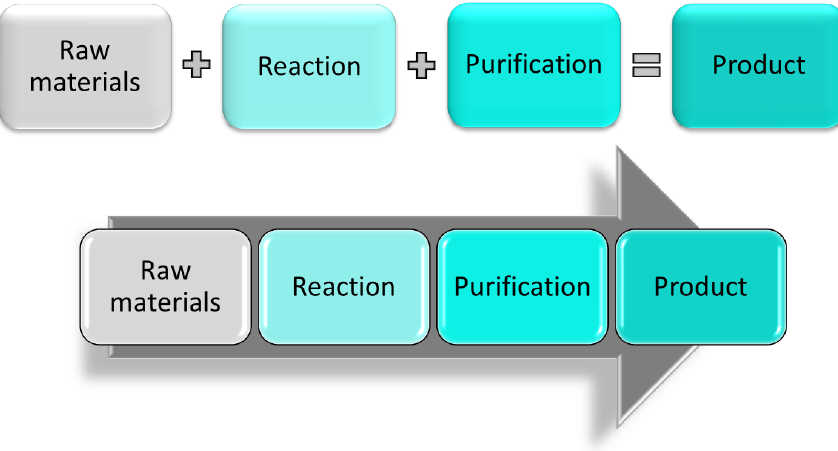
Figure 1. Stepwise batch manufacturing ( top ) and continuous manufacturing ( bottom ) representa- tion.